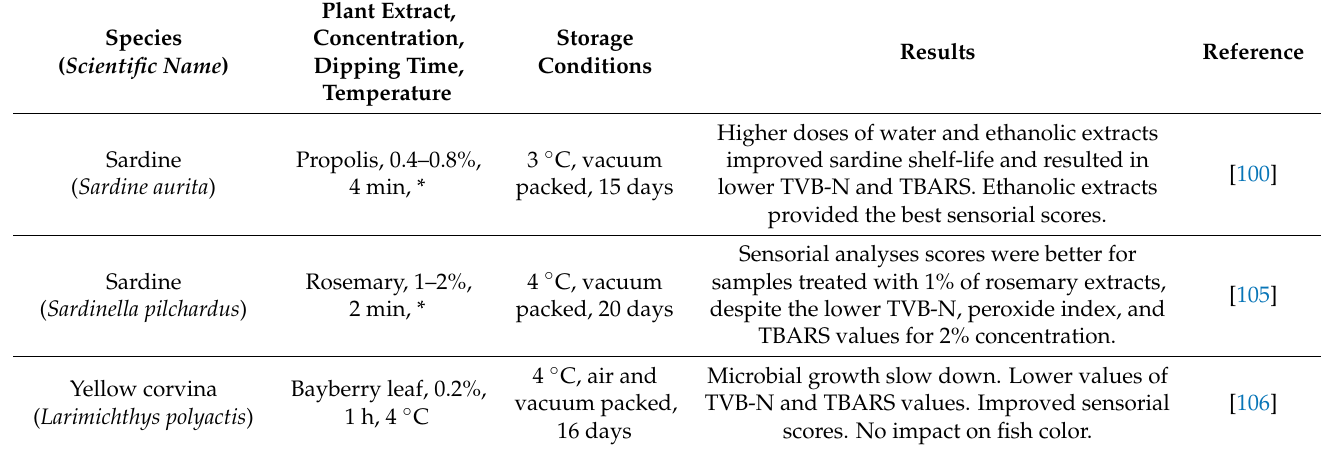
Table 6. Examples on the application of single and combined natural extracts from plants with other hurdle techniques on fresh fish and their effects on fish quality